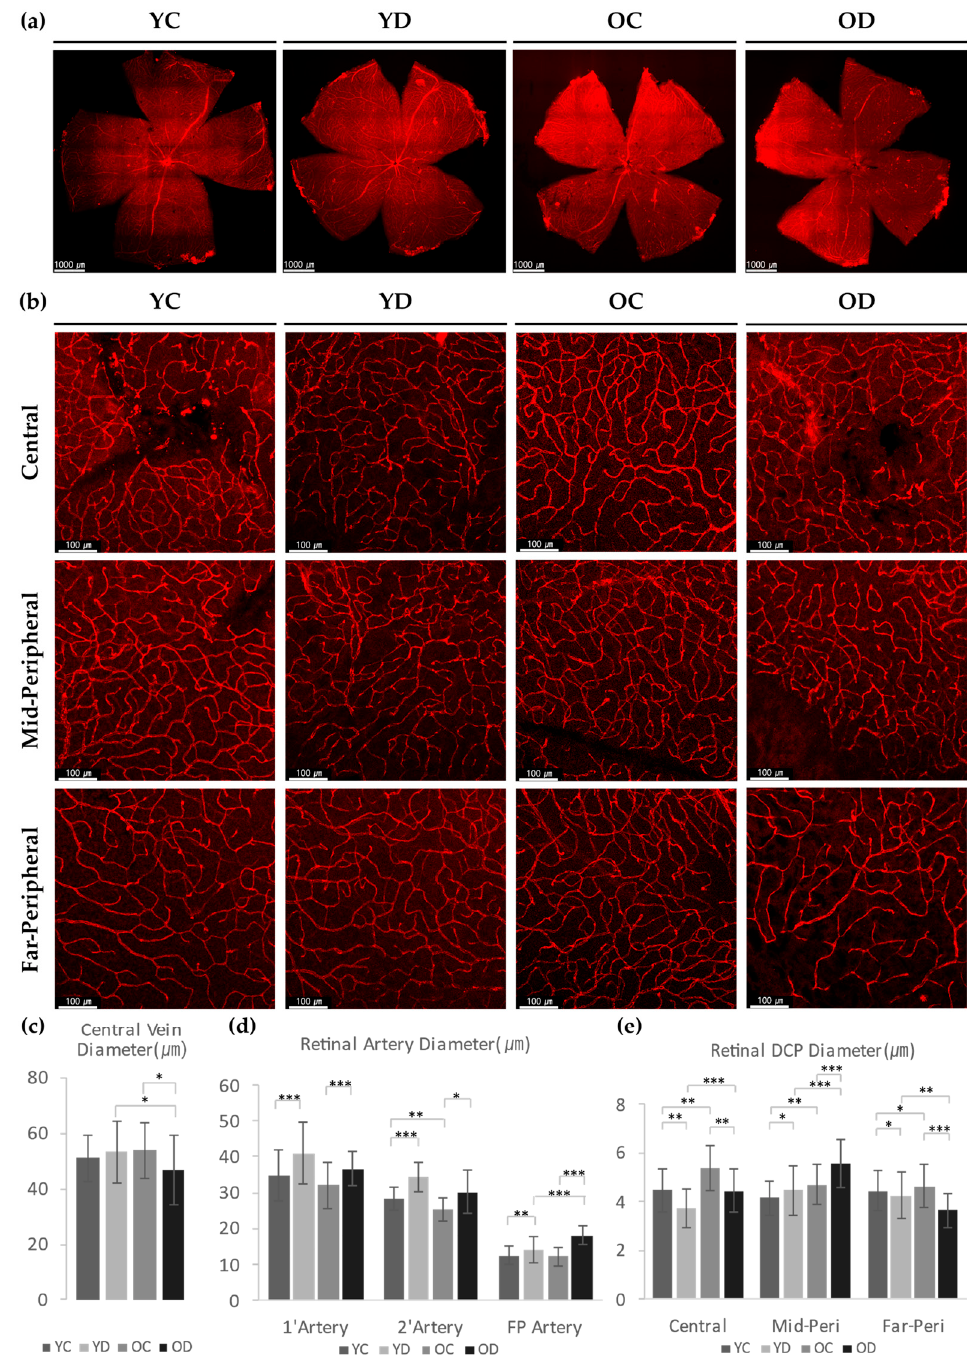
Figure 6. Retinal blood vessels in a diabetic model. ( a ) Wholemount retinas with CD31 staining for blood vessels. ( b ) Retinal deep vessels stained with CD31 at three di ff erent regions; central, mid-peripheral, far-peripheral. ( c ) The diameter of the central veins from each group. Each sample was measured with at least 8 di ff erent points. ( d ) Retinal artery diameters were analyzed. Each sample was measured with at least 10 di ff erent points per arteries of interest. ( e ) Retinal deep capillary diameters from three regions of each group were analyzed. Each sample was measured with at least 20 di ff erent points. ( c – e ) 4 di ff erent samples were analyzed and averaged per group. Error bars indicate SD. (( c ) Student’s t -test, N ( c ) = 32 per group; ( d , e ) 2-way Anova tested, N ( d ) = 40, N ( e ) = 80 per group; * p < 0.05, ** p < 0.01, *** p < 0.001) . In the choroid, we evaluated the average diameter of the major choroidal arteries: 1st and 2nd order choroidal arterioles, and 3rd and higher-order choroidal arterioles. Both aged groups had